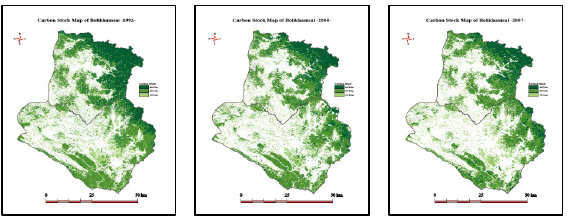
Figure 7. Forest carbon stock e stimation (BLK) based on biomass